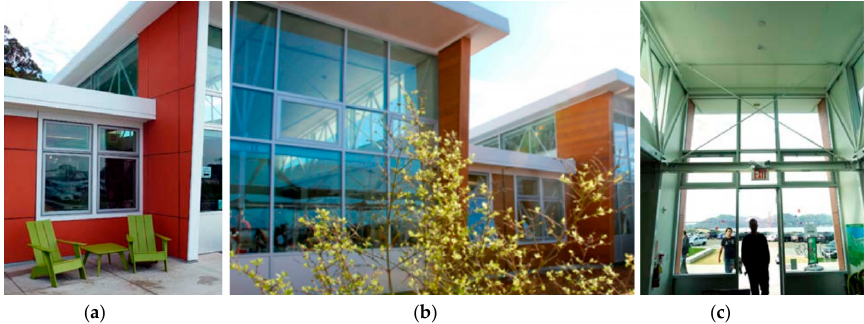
Figure 4. Project Frog’s Crissy Field project, San Francisco ( a , b ) exterior view; ( c ) interior. Images: Future Proofing Schools. Future Proofing